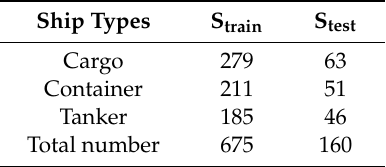
Table 2. ResNet18 training set and test set.